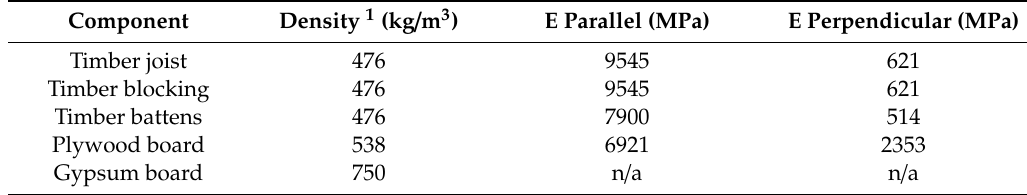
Table 1. Nominal density and Young’s modulus (E) of timber floor components.